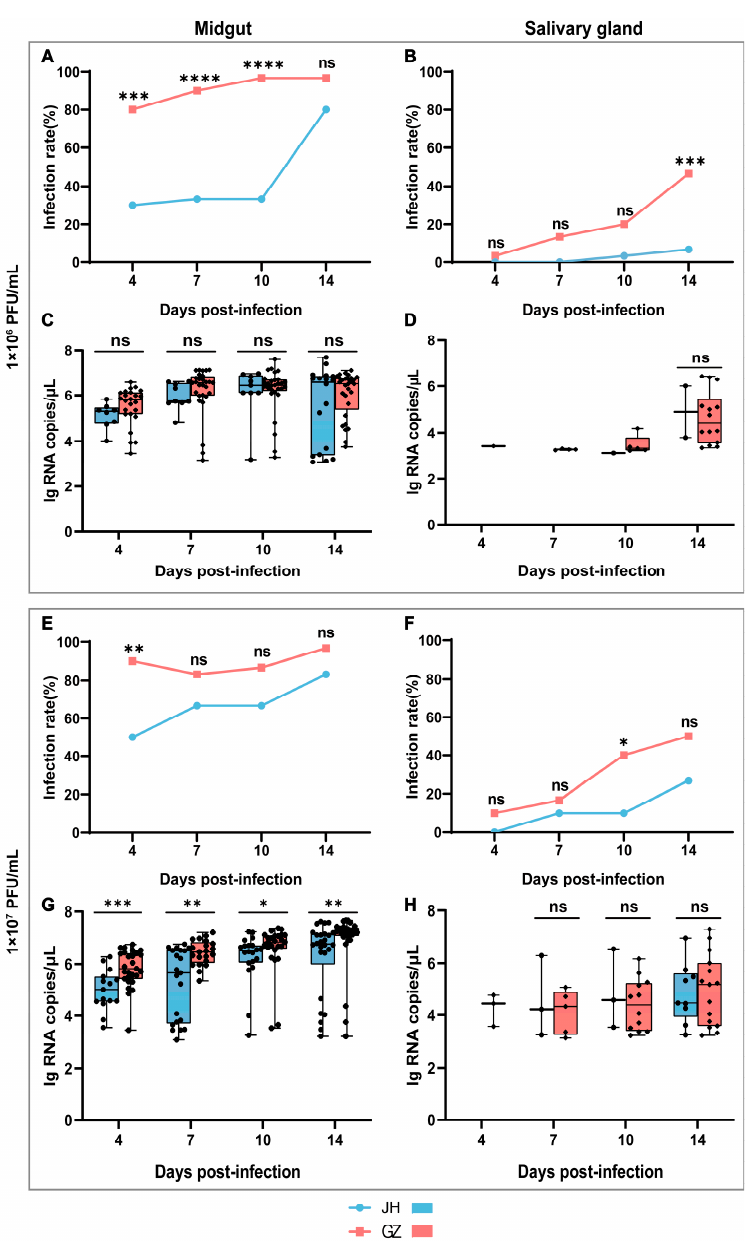
Figure 1. Vector competence of Ae. albopictus JH and GZ strains to ZIKV. The upper panel shows the results of the infection rate and viral RNA copies in two Ae. albopictus strains infected with a low dose of ZIKV (1 × 10 6 PFU/mL), and the lower panel shows the results of a high dose of ZIKV infection (1 × 10 7 PFU/mL). Infection rate in the midgut ( A , E ) and salivary gland ( B , F ) of two mosquito strains. Viral RNA copies (log 10 transformation) in the midgut ( C , G ) and salivary gland ( D , H ) of two mosquito strains. The infection rate of the two Ae. albopictus strains were compared using Fisher’s exact test, and viral RNA copies were compared using the non-parametric Mann–Whitney test (Mann–Whitney test requires at least two values in each group; the data that did not meet this standard were not compared) to determine the differences between the two strains at different times, since the viral RNA copies did not conform to a normal distribution (Shapiro–Wilk test). Box plots show the median and the 25th to 75th percentiles, and the whiskers denote the minimum and maximum values. * p < 0.05, ** p < 0.01, *** p < 0.001 and **** p < 0.0001, ns: no significant